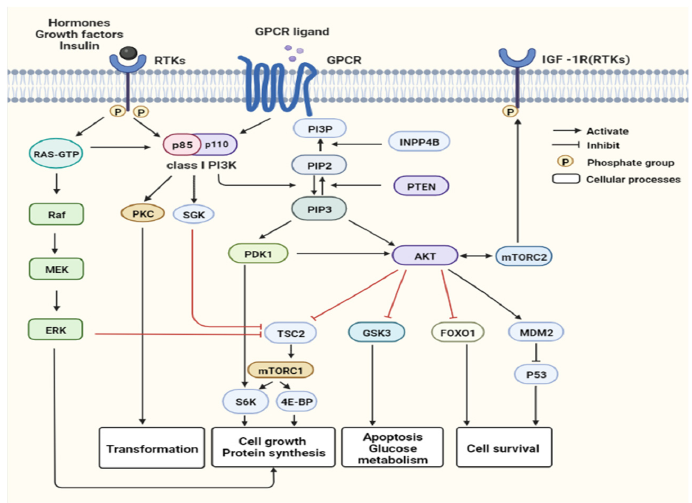
Figure 2. The PAM signaling pathways. PAM pathway can be activated by G protein-coupled receptor (GPCR) and receptor tyrosine kinases (RTKs), including human epidermal growth factor receptor 2 (HER2/ERBB2), fibroblast growth factor receptor (FGFR), insulin and insulin-like growth factor-1 receptor (InsR/IGF-1R), which PtdIns (4,5) P2 (PIP2) to generate the second messenger PtdIns (3,4,5) P3 (PIP3) [6]. PTEN (phosphatase and tensin homolog) dephosphorylates PIP3 to generate PIP2, while INPP4B (inositol polyphosphate-4-phosphatase type II B) dephosphorylates PtdIns(3,4)P2 to generate PtdIns(3)P (PI3P). Proteins, containing a pleckstrin homology (PH) domain, are recruited to the cytomembrane by PIP3, including AKT, 3-phosphoinositide-dependent kinase 1 (PDK1), and serum and glucocorticoid-induced kinase (SGK). The main downstream target of PI3K is AKT. It is activated by PDK1 and mTOR complex 2 (mTORC2), and phosphorylates a large number of downstream effector proteins, including mTOR complex 1 (mTORC1), forkhead box protein O1 (FoxO1), glycogen synthesis kinase (GSK3) and murine double minute 2 (MDM2). The AKT-mediated phosphorylation of GSK3 β , FOXO1 and MDM2 directly or indirectly controls cellular growth and survival. The activated mTORC1 ultimately regulates cellular processes, such as the initiation of mRNA transcription, cell growth, autophagy and protein synthesis, via phosphorylation of 4EBP1 and S6K1 [1,7]. In addition, mTORC2 can phosphorylate both IGF-1R and AKT [8]. S6K-mediated phosphorylation of PDK1 negatively feed back to inhibit PDK1 [7]. PKC and SGK are also involved in PI3K signaling independent of AKT.